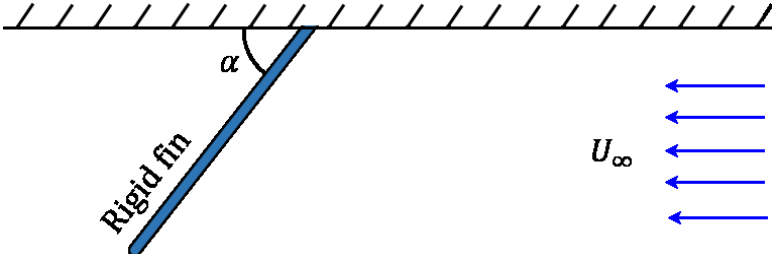
Figure 3. Schematic of the rigid inclined fin immersed in fluid at the bottom of the